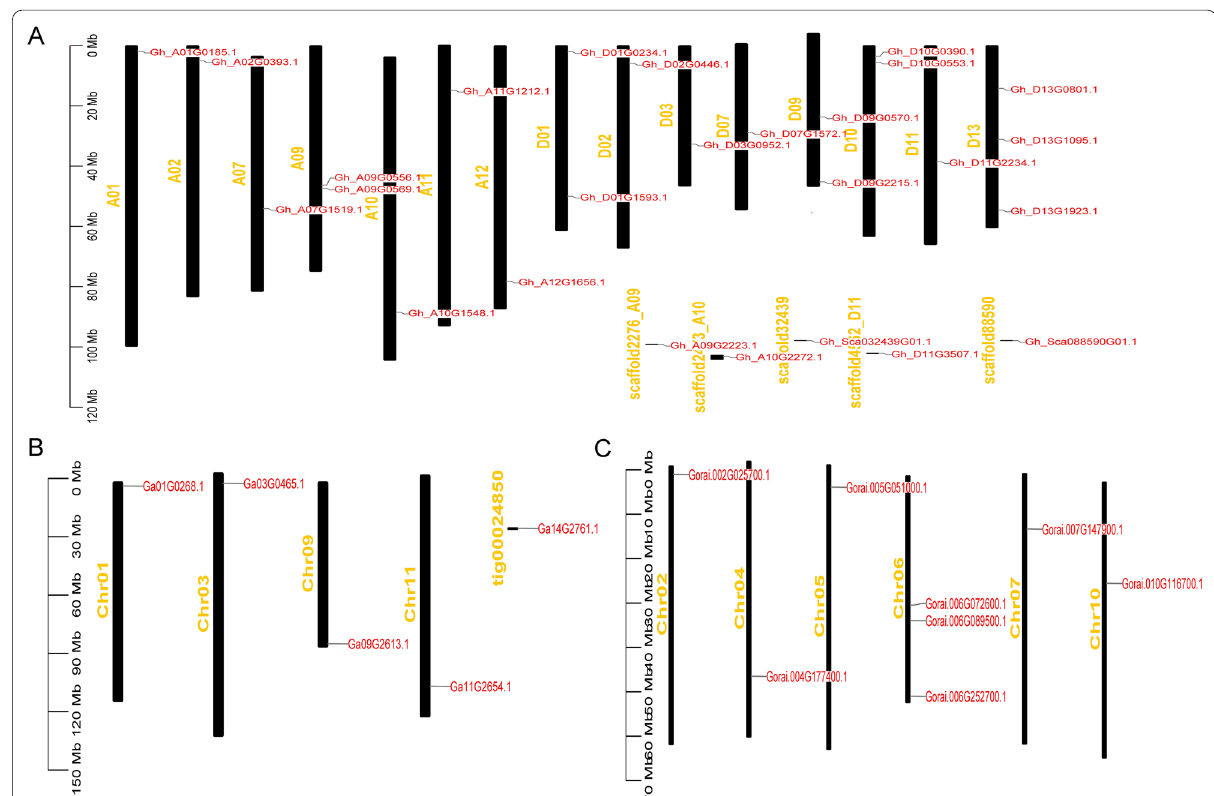
Fig. 2 The distribution of RPL14B genes in chromosomes. A G. hirsutum , B G.raimondii and C G.